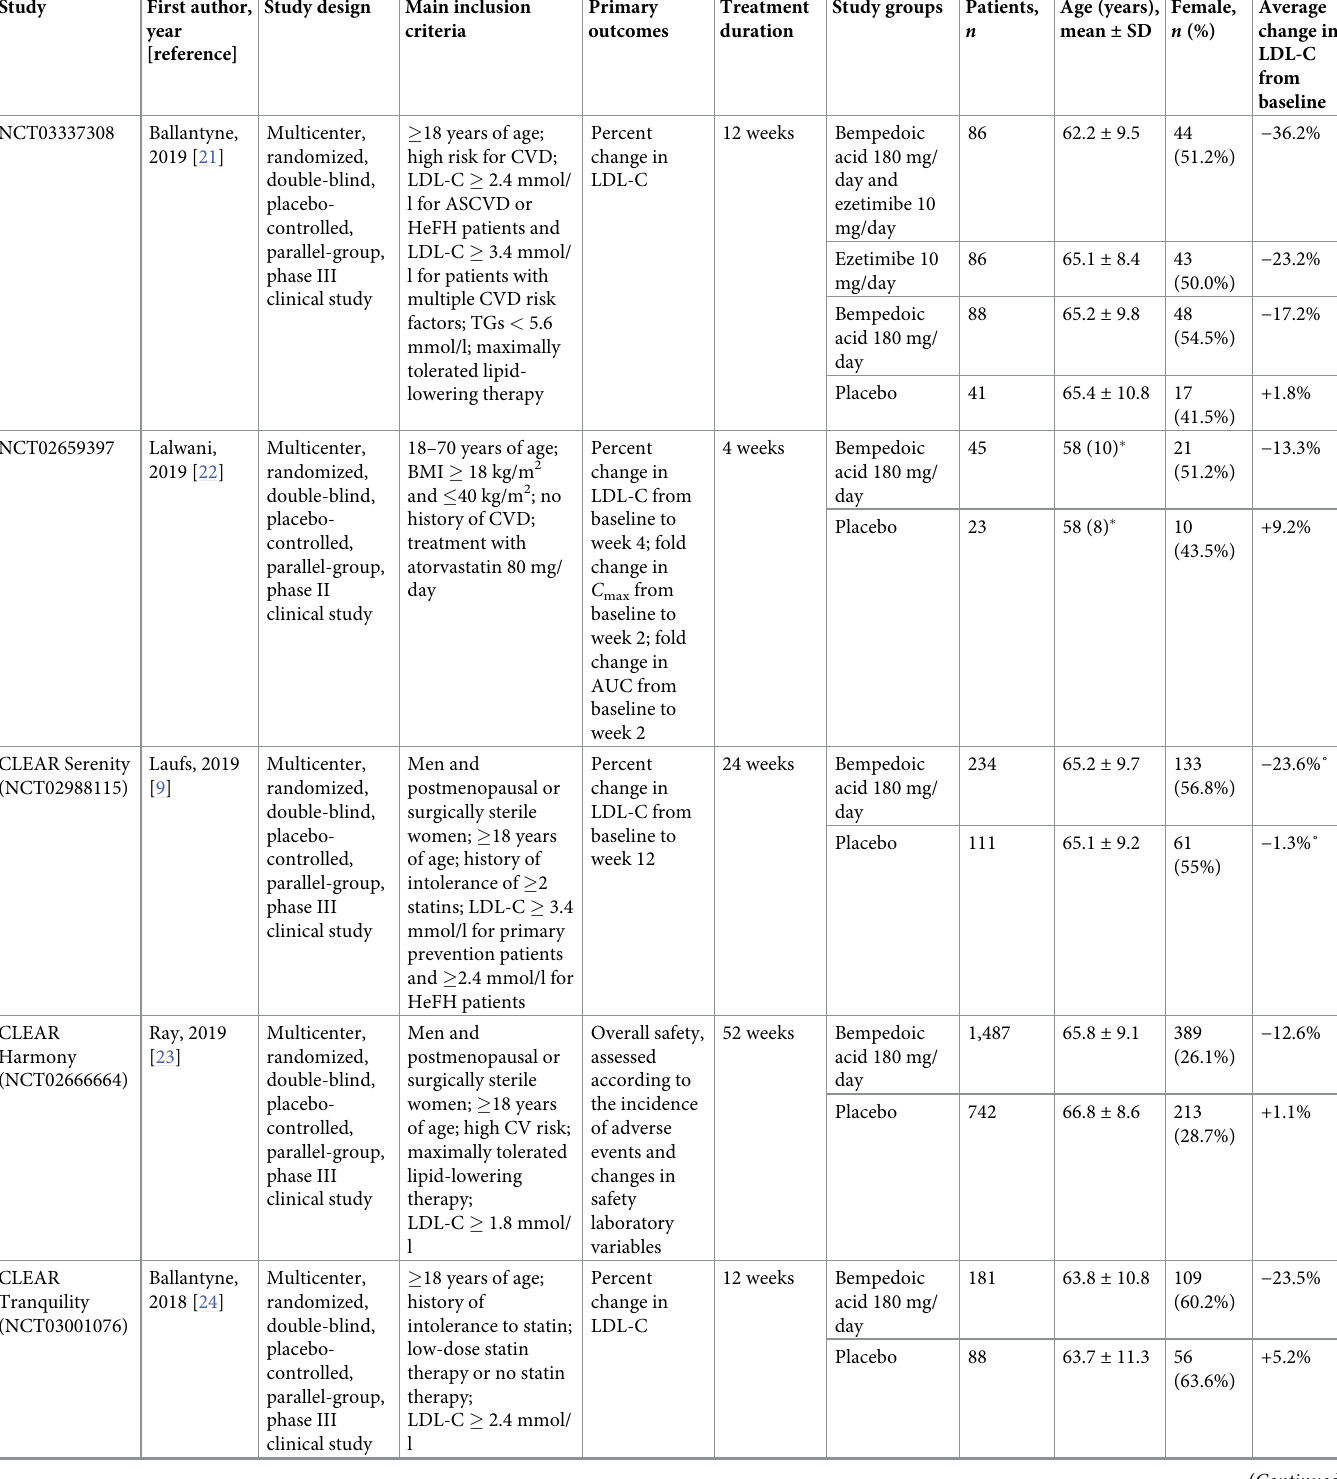
Table 1. Main characteristics of the selected